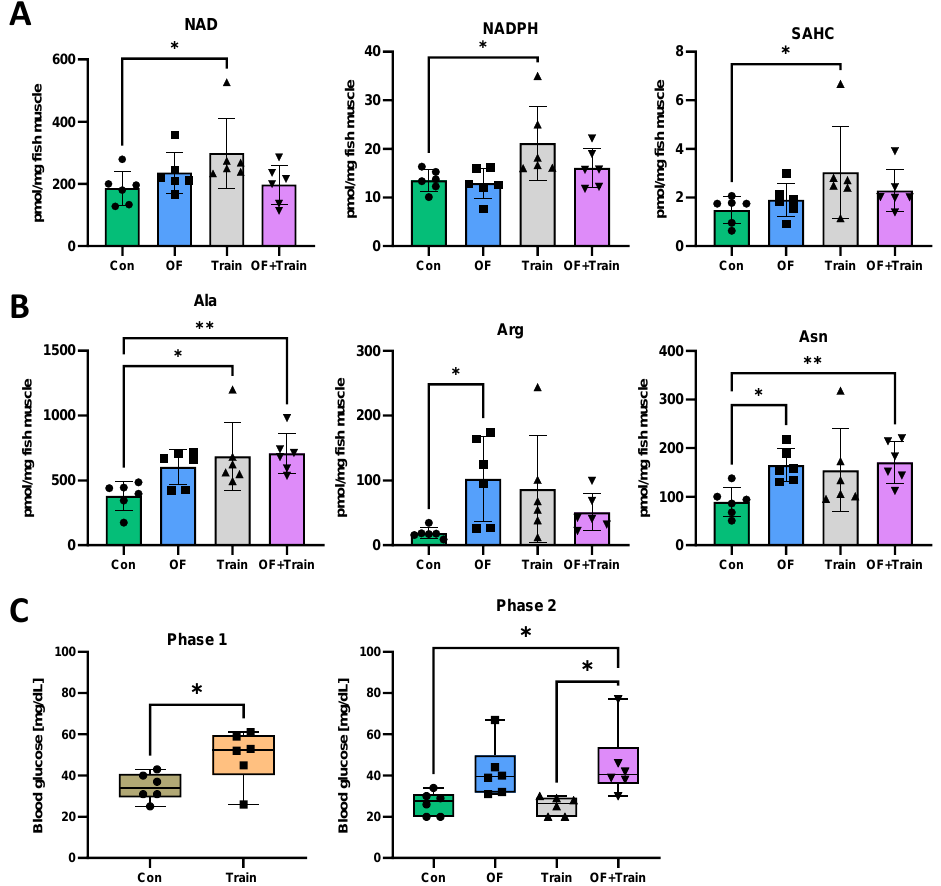
Figure 4. Swim tunnel training significantly altered the metabolome in zebrafish muscle. ( A ): increased concentrations of adenosine levels in trained zebrafish. NAD: nicotinamide dinucleotide, NADPH: nicotinamide dinucleotide phosphate, SAHC: S-adenosyl-homocysteine. N = 6 fish per group. ( B ): Alterations on amino acid levels in trained and overfed zebrafish. Ala: Alanine, Arg: Arginine, Asn: Asparagine. N = 6 fish per group. ( C ): Alterations on fasting blood glucose level. In phase 1 experiment, blood glucose was measured directly after the last training session whereas blood glucose was measured 24 h later in phase 2 experiment. Con: Control; OF: overfeeding; Train: Training. N = 6 fish per group. Statistical tests: Two-tailed unpaired t-test (phase 1) and one way ANOVA test or Kruskal-Wallis test (phase 2). * p < 0.05, ** p < 0.01. 3.5. Swim Training Alters the Transcriptional Profile Linked to Energy Metabolism and Oxidative Stress In order to identify transcriptional adaptations linked to physical performance in zebrafish, we performed RNA sequencing in liver tissue. When pathway analysis was performed comparing training effects against the control group, we observed upregulated pathways such as “ATP metabolic process”, “oxidative phosphorylation”, or “cellular re- sponse to oxidative stress” (Figure 5A). Due to the increased energy generation, other bi- ological processes were decreased, such as “chromosome organization” or “RNA pro- cessing” appeared to be downregulated. “Oxidative phosphorylation” was also upregu- lated in the OF-control group compared to the NF- control group, as well as “translation” and “mitochondrion organization” (Figure 5B). Downregulated pathways were here more heterogeneous including “immune response” and “cell cycle process” pathways. To- gether, the data show a metabolic and transcriptional adaptation to the increased physical performance and to increased calorie intake in zebrafish.